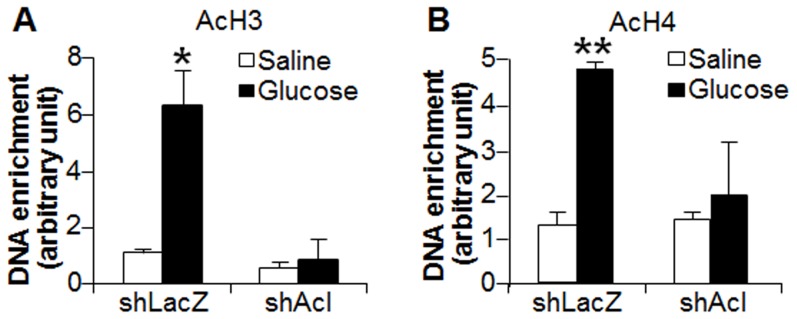
ACL is required for glucose-mediated acetylation of histones (H3, H4) in the CES1 chromatin.(A, B) C57BL/6 mice were treated as described in Fig. 3B–F. Liver lysates were used for ChIP assay to determine acetylation of histone 3 (AcH3) (A) and histone 4 (AcH4) (B). *p<0.05, **p<0.01.